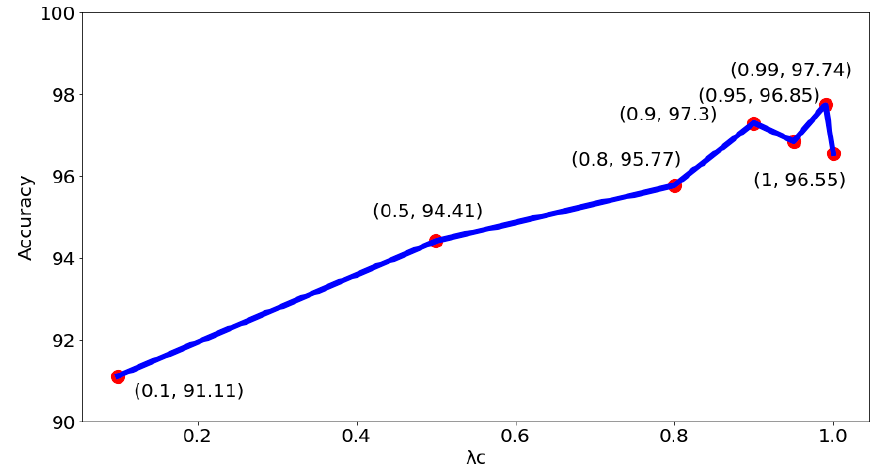
Figure 10. The segmentation results of the proposed method: ( a ) the input images; ( b ) segmented results of our method.